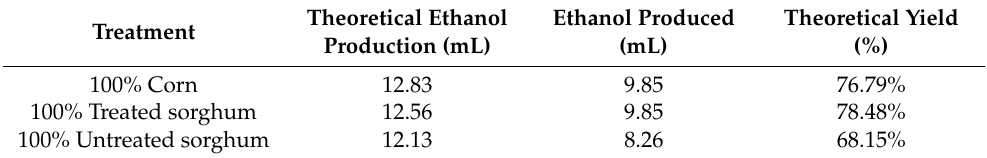
Table 2. Average theoretical yield (%) of sorghum fermentations, no cellulase added.